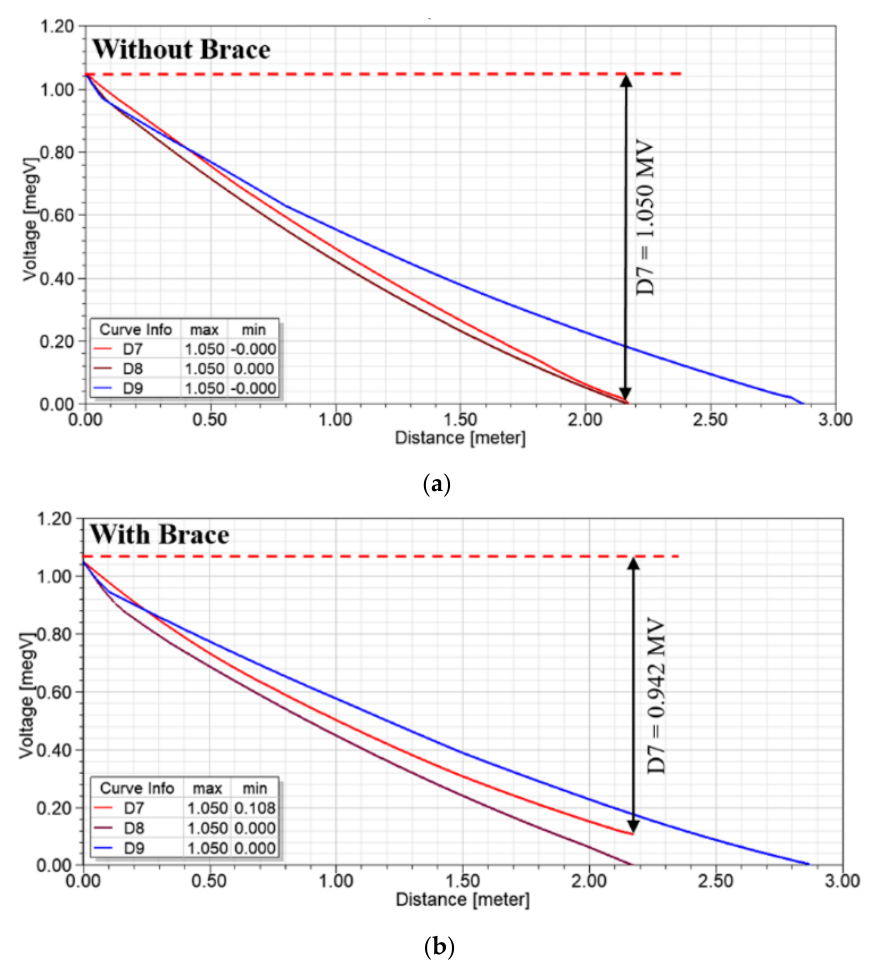
Figure 11. Potential distribution along D7, D8, and D9 considering a 57° pivoted insulator for the case ( a ) without a brace and ( b ) with a brace.